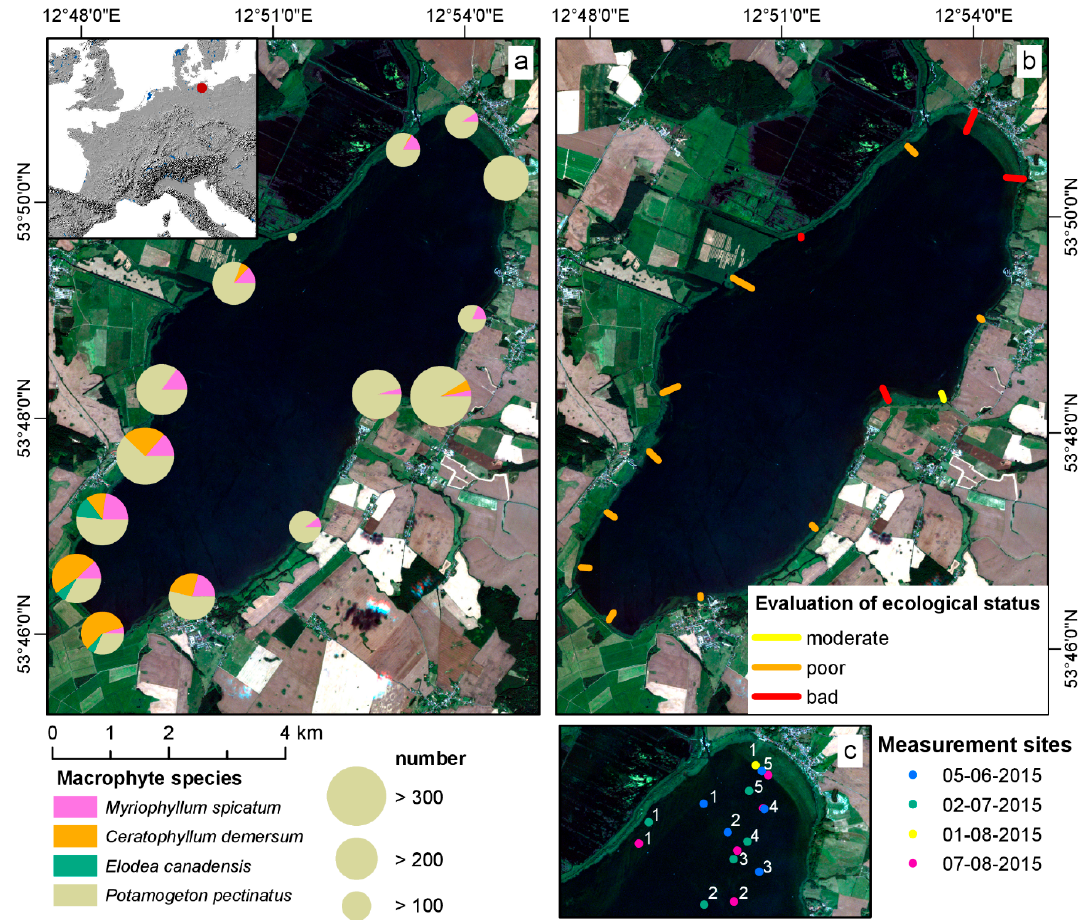
Figure 1. The study area Lake Kummerow. ( a ) Share of macrophyte species used in ecological status assessment at each transect. The size of circles indicates the number of macrophytes found within each transect; ( b ) Length and ecological status of transects according to PHYLIB; ( c ) Date and position of the in situ measurement sites. Background shows a RapidEye true-colour-composite (1 August 2015). Contains material © (2015) Planet Labs. All rights reserved.